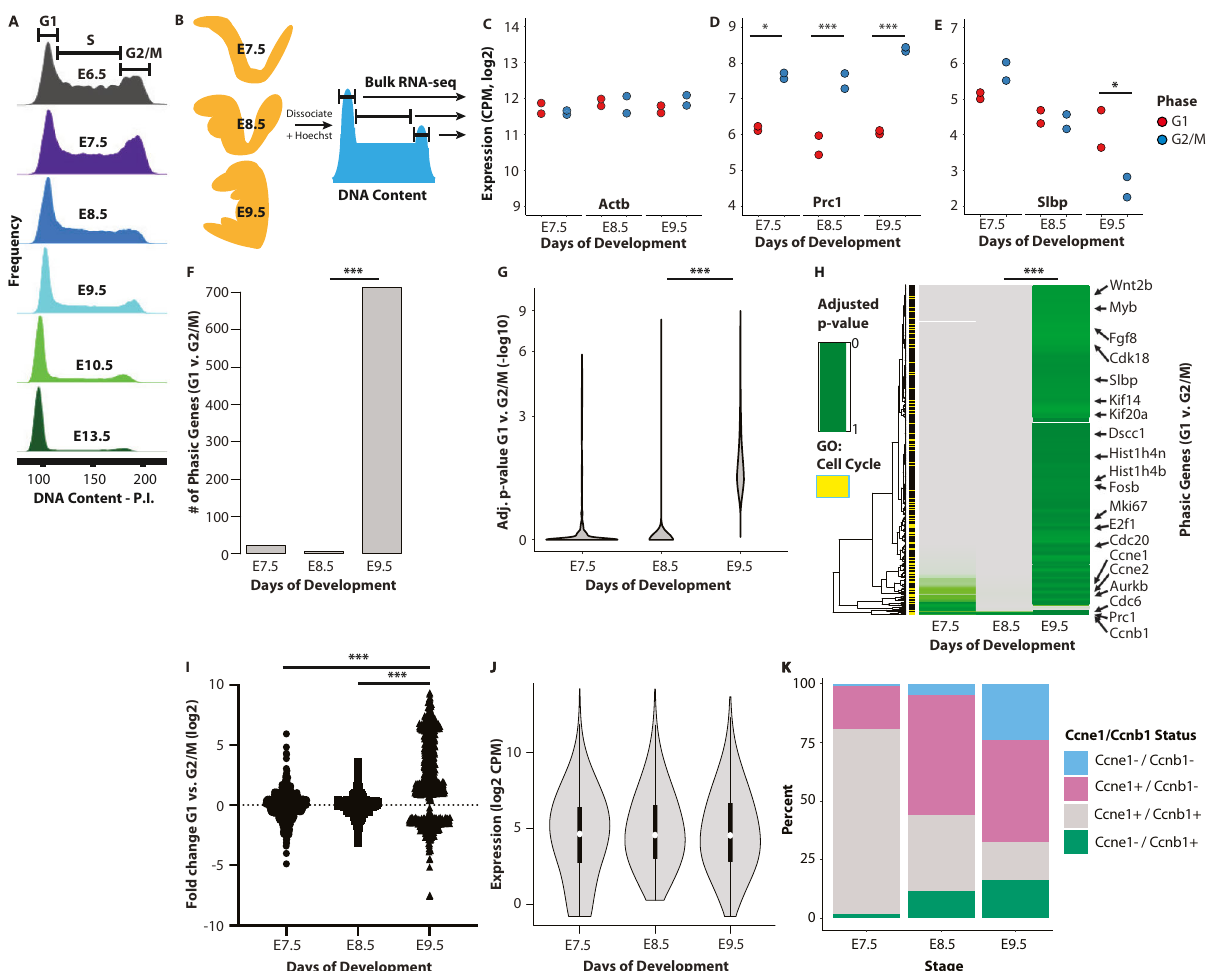
Fig. 1 Gain of phasic expression following gastrulation. A DNA-content analysis of cells from whole embryos ranging from embryonic day 6.5 (E6.5) to E13.5 (representative litters, n = 2 biologically independent samples for each stage, embryos from each litter were pooled). B Schematic of the data collection and analysis. E7.5, E8.5, and E9.5 embryos were dissociated to single cells, sorted by cell cycle phase based on DNA-content, and subjected to RNA-sequencing for differential expression analysis between the phases at each timepoint. C – E The expression of Actb ( C ), Prc1 (adjusted P value (adj. P ), * P = 0.029 [E7.5]; *** P = 0.00017 [E8.5]; *** P = 1.02e − 9 [E9.5]) ( D ) and Slbp (* adj. P = 0.05) ( E ) at each developmental stage. n = 2 biologically independent litters for each stage and phase. Litters of 6 and 4 embryos at E7.5, 8 and 6 embryos at E8.5, and 3 and 5 embryos at E9.5 were pooled. F The number of genes showing differential expression between G1 and G2/M (adj. P < 0.1) increases between E7.5 and E9.5 (*** P < 0.001, Chi-square test). G The distribution of adjusted P values at each developmental stage for union of all genes identi fi ed in F (*** P < 0.001, Wilcoxon Rank Test, two-sided). H Heat map of P values for all genes shown in G (*** P < 0.001, Wilcoxon Rank Test, two-sided). I The distribution of fold-change values for all genes shown in G (*** P < 0.001, Tukey ’ s post hoc, one-way ANOVA). J The distribution of log2 counts per million for all genes shown in ( G ) (no signi fi cant change, P > 0.5, one-way ANOVA, n = 714 genes). White dot, median. Box edges, 25th and 75th quartiles. Whiskers, 1.5× the IQR of the box edge. K The relative